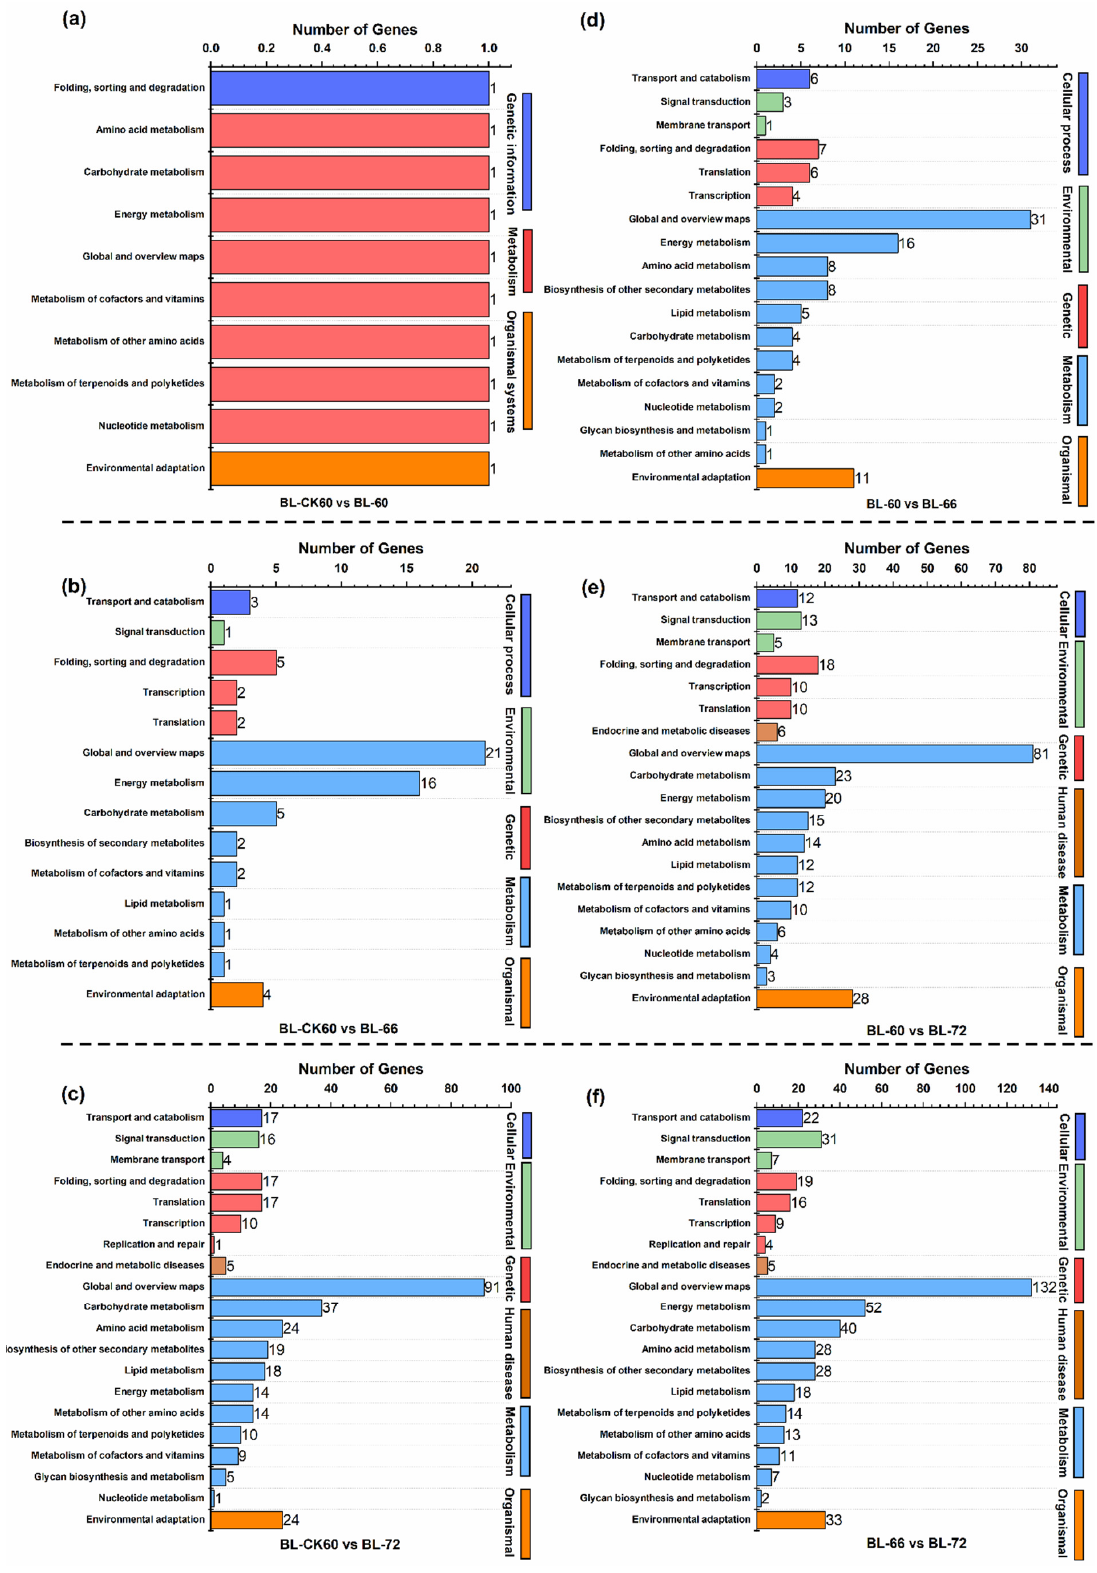
Figure 4. KEGG pathway classification of DEGs between control and treatment and among treatments at three tested time points (60 h, 66 h, and 72 h); ( a–c ) KEGG pathway classification of DEGs between control and treatment at tested time points (60 h, 66 h, 72 h); ( d–f ) KEGG pathway classification of DEGs among treatment comparisons at tested time points (60 h, 66 h, 72